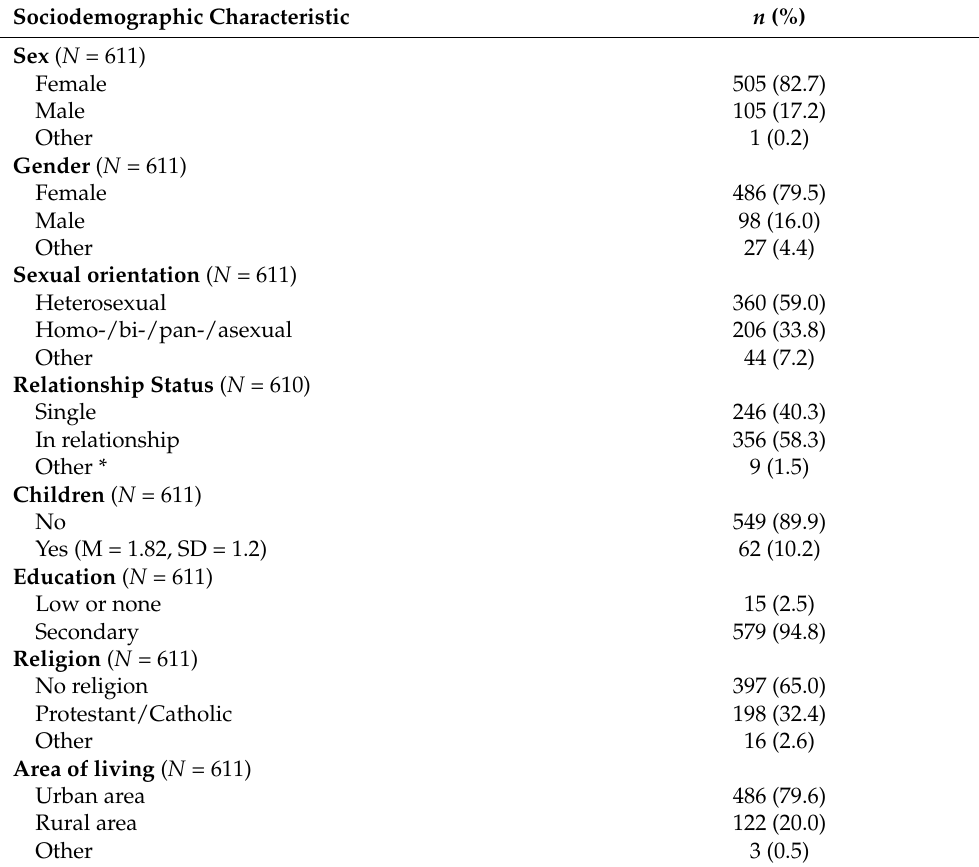
Table 2. Sociodemographic characteristics of